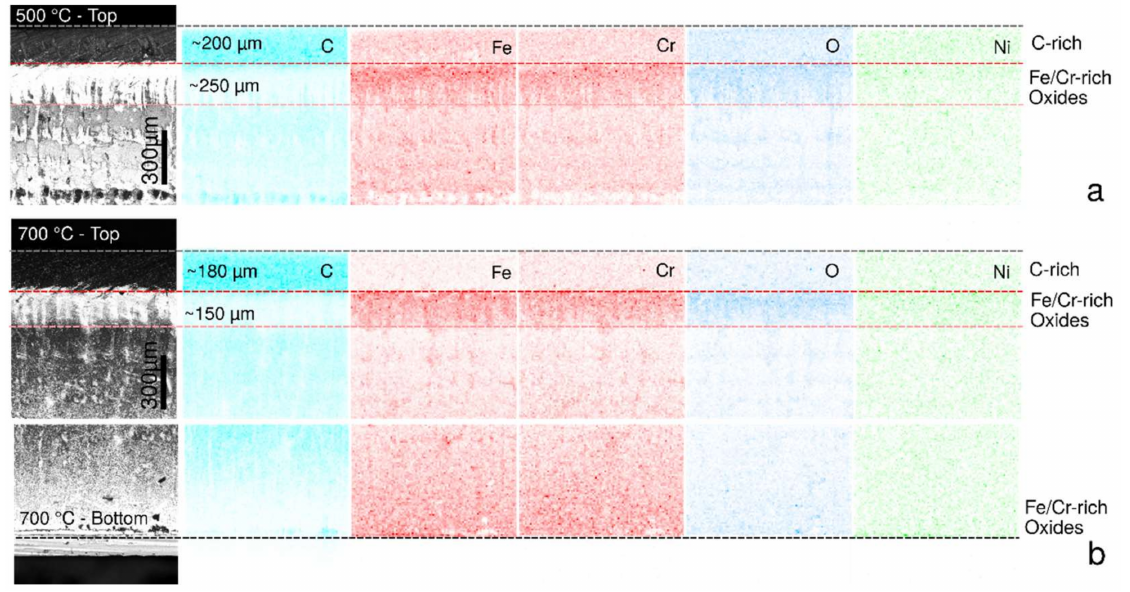
Figure 5. EDX of sample cross-sections deposited at ( a ) 500 ◦ C and ( b ) 700 ◦ C.